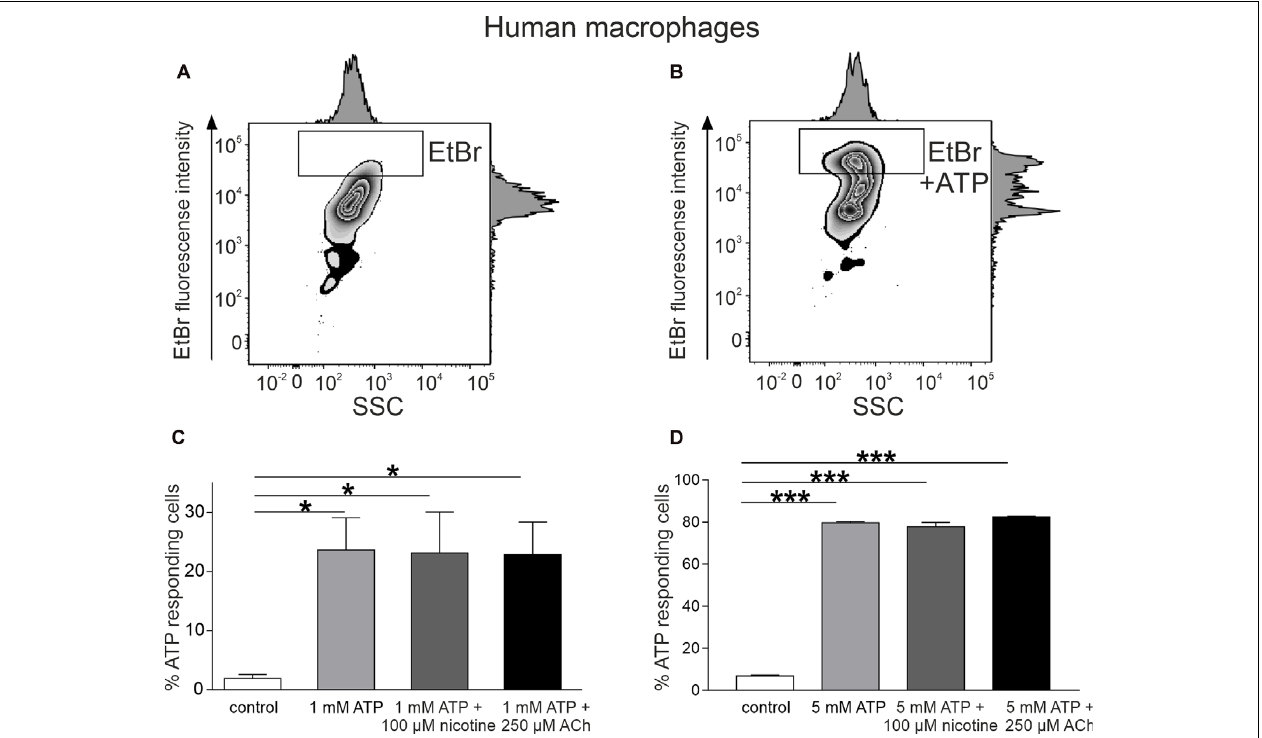
FIGURE 4 | ATP-induced ethidium bromide (EtBr) uptake into monocyte-derived macrophages (MDMs). (A) Representative histogram of EtBr uptake in control. (B) Representative histogram of EtBr uptake in the presence of 1 mM ATP at 37 ◦ C for 10 min. (C) Histograms showing percent of EtBr-positive cells in control (white, n = 5), in the presence of ATP 1 mM (light gray, n = 5) alone, and after preincubation with 100 µ M nicotine (dark gray, n = 5) or 250 µ M acetylcholine (black, n = 5). (D) Histograms showing percent of EtBr-positive cells in control (white, n = 5), in the presence of ATP 5 mM (light gray, n = 3) alone, and after preincubation with 100 µ M nicotine (dark gray, n = 3) or 250 µ M acetylcholine (black, n = 3). Mean ± SEM, * p < 0.05, *** p < 0.0001 (one-way ANOVA, followed by Tukey’s post hoc